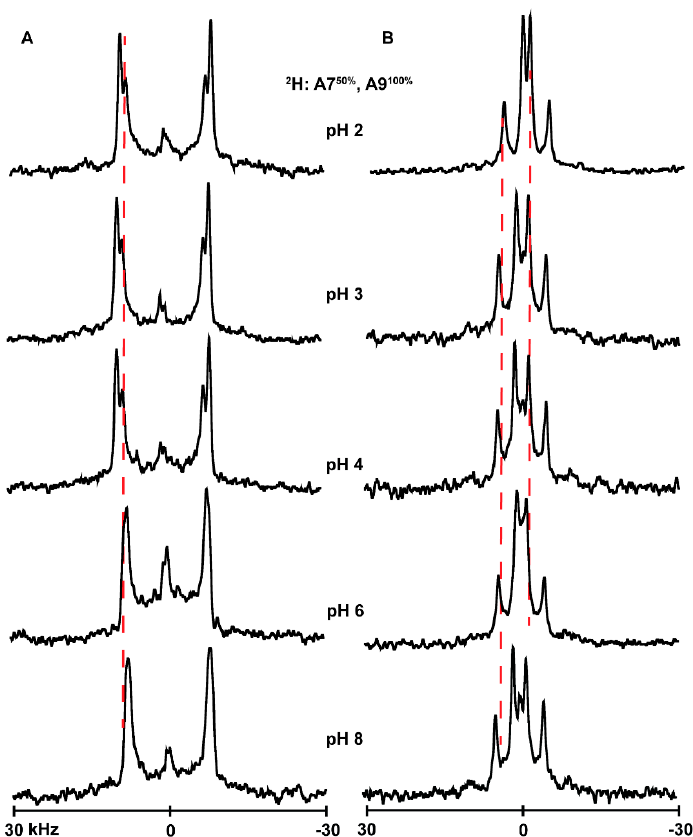
Figure 6. Selected 2 H NMR spectra to show the pH dependence of resonances for labeled A7 and A9 of H 2,22 WALP23 in DLPC ( A ) and DOPC ( B ) lipid bilayers. Temperature 50 ◦ C; β = 90 ◦ sample orientation.